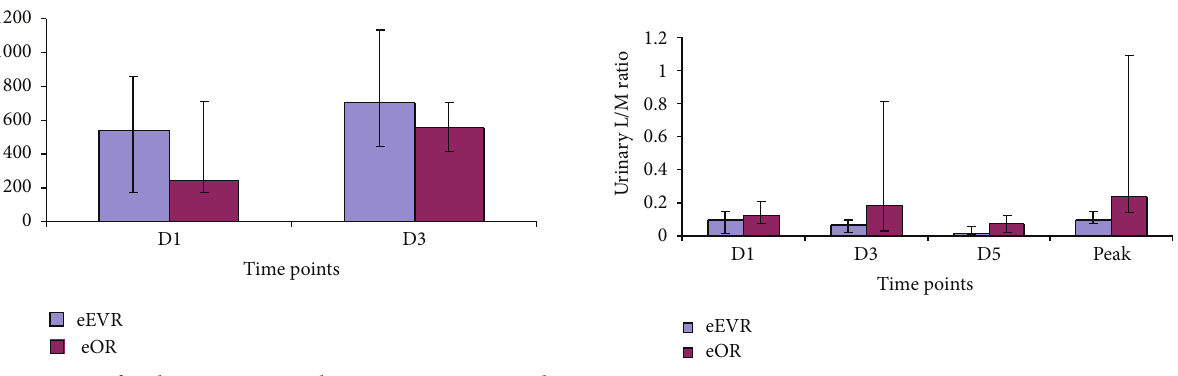
Figure 10: Lactulose/mannitol excretion ratio (median, IQR). At D3, 𝑃 = 0.02 and at peak, 𝑃 = 0.03 (eEVAR versus eOR) (Mann Whitney 𝑈